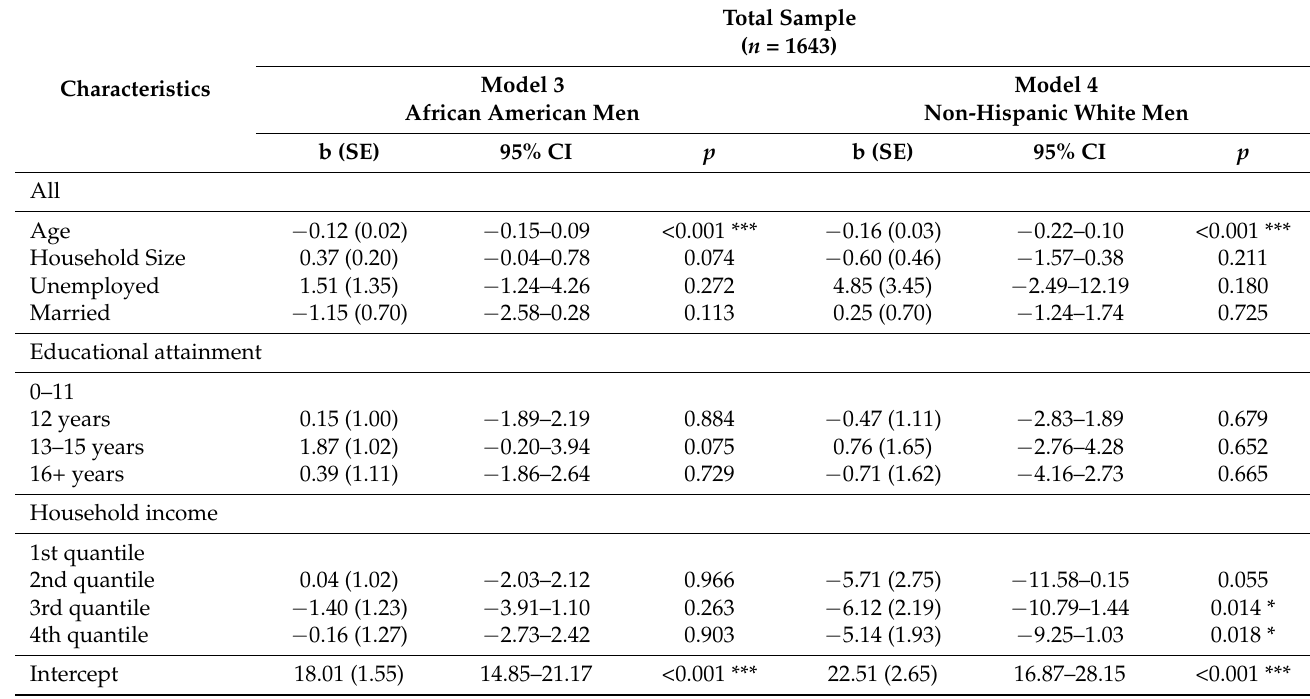
Table 3. Summary of linear regression on the effects of education attainment and household income on perceived discrimi- nation by race among men in the National Survey of American Life